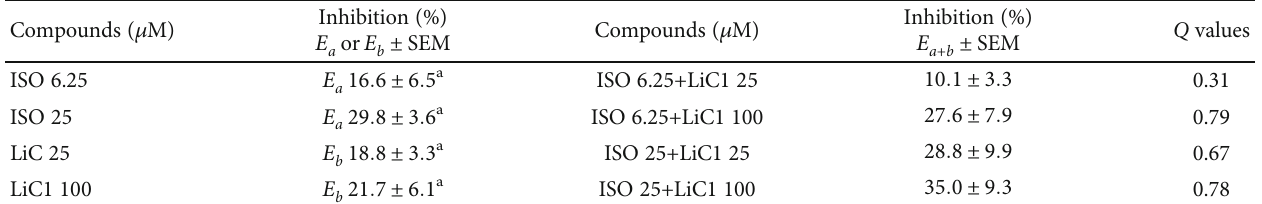
Table 1: E ff ects of coadministered isoorientin (ISO) and LiC1 in RAW264.7 cells ( mean ± SEM , n = 3 ). Compounds ( μ M)